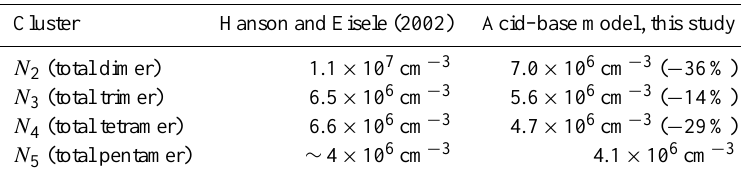
Table 3. Comparison between measured cluster concentrations by Hanson and Eisele (2002) and simulated cluster concentrations using the acid–base model described in Sect. 3.6.